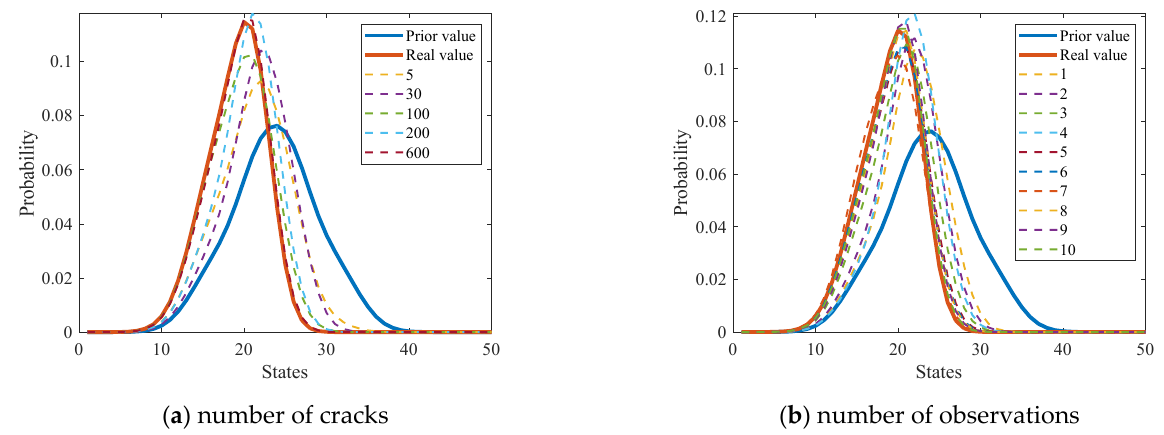
Figure 12. Probability distribution updating of initial crack length with the increasing number of ( a ) considered cracks and ( b ) adopted observations.